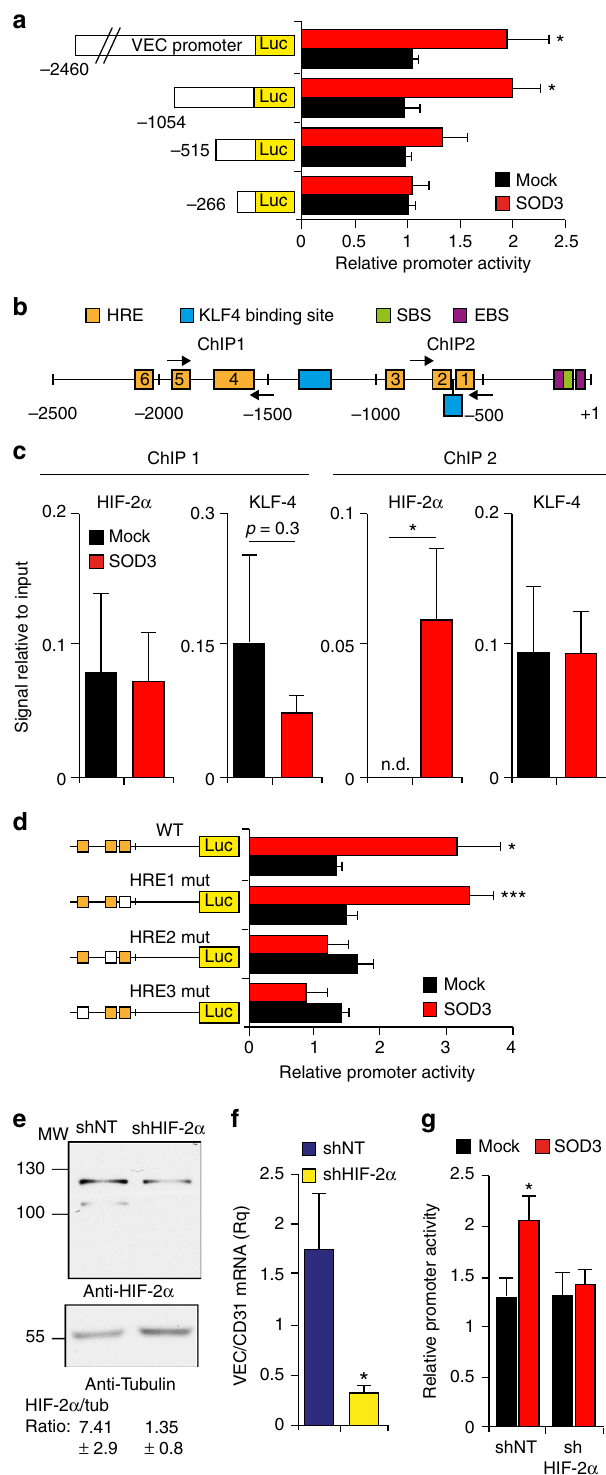
Fig. 5 HIF-2 α mediates SOD3-induced VEC transcription. a Relative luciferase activity (RLU) in 1G11 cells cotransfected with SOD3 (or mock) and the full-length VEC promoter or deletion mutants. Values were normalized to the signal in 1G11-mock cells for each promoter ( n = 4). b Full-length (~2.5 kb) VEC promoter with binding sites for the main transcription factors. Numbers indicate positions relative to the transcription start site. HRE hypoxia response element, SBS Sox-binding site, EBS Ets-1-binding site. c ChIP analysis of VEC promoter in mock- and SOD3-transfected 1G11 cells using anti-HIF-2 α and -KLF-4 antibodies. Coprecipitated DNA fragments were PCR-quanti fi ed using primers in a (arrows; n = 5). d RLU in 1G11-mock or -SOD3 cells transfected with VEC promoter HRE mutants. The mutated HRE site is indicated (white square; n = 10). e Immunoblot analysis of control (shNT) and HIF-2 α -silenced (shHIF-2 α ) 1G11 cells ( n = 3). The HIF-2 α :tubulin densitometry ratio is shown (bottom). f VEC mRNA levels, using CD31 as reference, in cells as in e . g Relative VEC promoter activity in control and shHIF-2 α -1G11 cells transfected with mock or SOD3 plasmids. Data shown